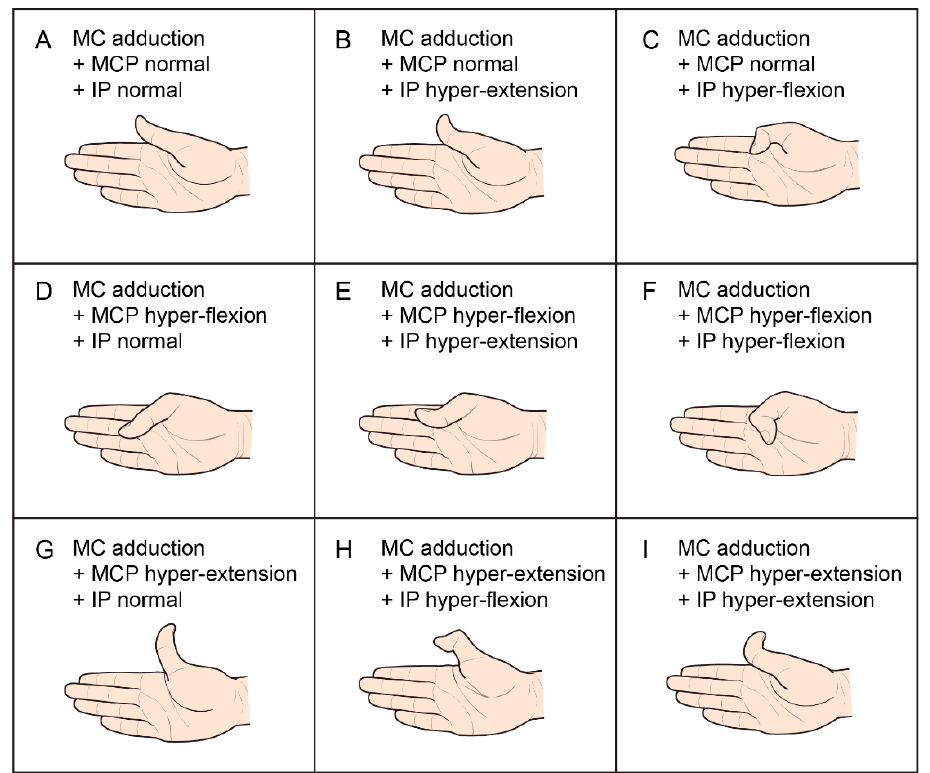
Figure 1. Thumb-in-palm deformities according to each joint level. MC, metacarpal; MCP, metacarpophalangeal; IP, interphalangeal joints; A = Ia, B = Ib, C = Ic, D = IIa, E = IIb, F = IV, G/H/I = III House thumb-in-palm classification.